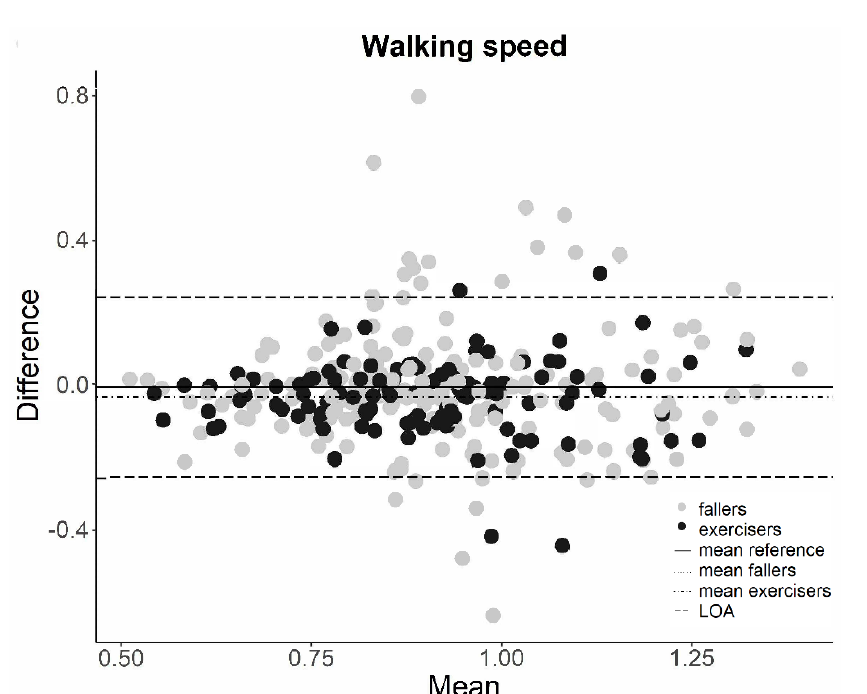
Figure A1. Change in walking speed between baseline and one-year follow-up set out against the mean walking speed of baseline and one-year follow-up of the fallers and exercises with LOA determined in the reference group. Note: Change beyond the upper LOA indicates an increase in walking speed, change beyond the lower LOA indicates a decrease in walking speed. Continuous line is mean change of the reference group. Long dashed lines are the LOA. Dotted line (mean change in the fallers) and dot-dashed line (mean change in the exercisers) are overlapping.